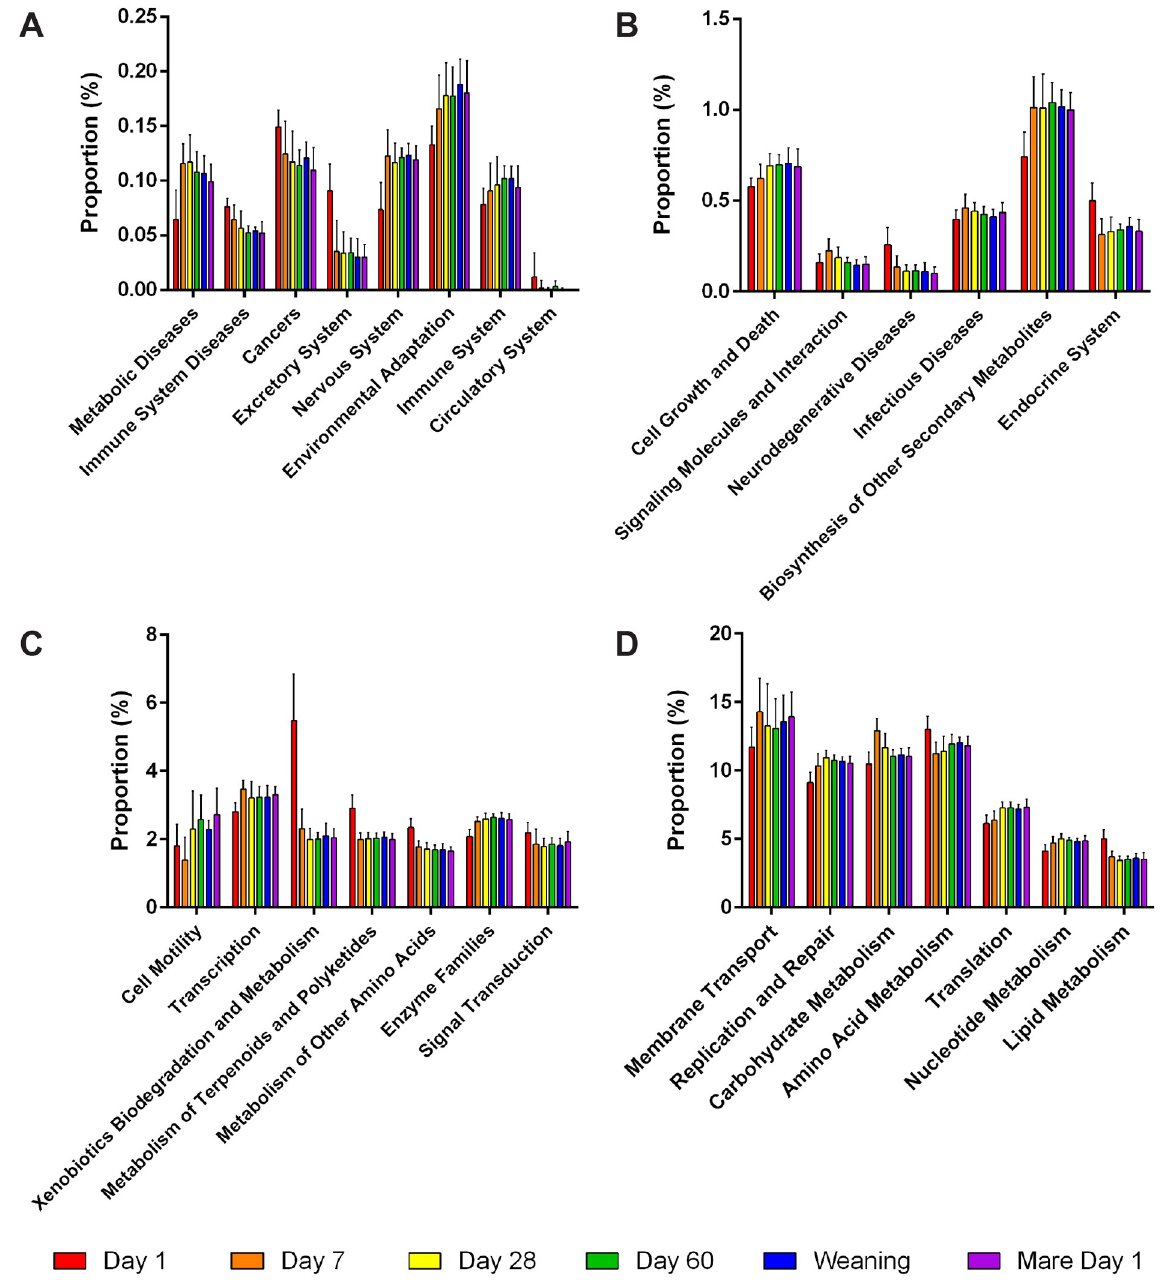
Fig 8. STAMP (STatistical Analysis of Metagenomic Profiles) was used to characterize functional roles of microbial populations in host biology by age. After Bonferroni correction, twenty-eight categories were considered to have differed significantly at some point in the transition of microbial populations from birth to weaning. In the above panels, the categories are divided by proportion ranges of (A) 0.0%— 0.25%, (B) 0.25% -1.5%, (C) 1.5%—8.0%, and (D) 5%—20%. Bars are represented as mean ± standard deviation.